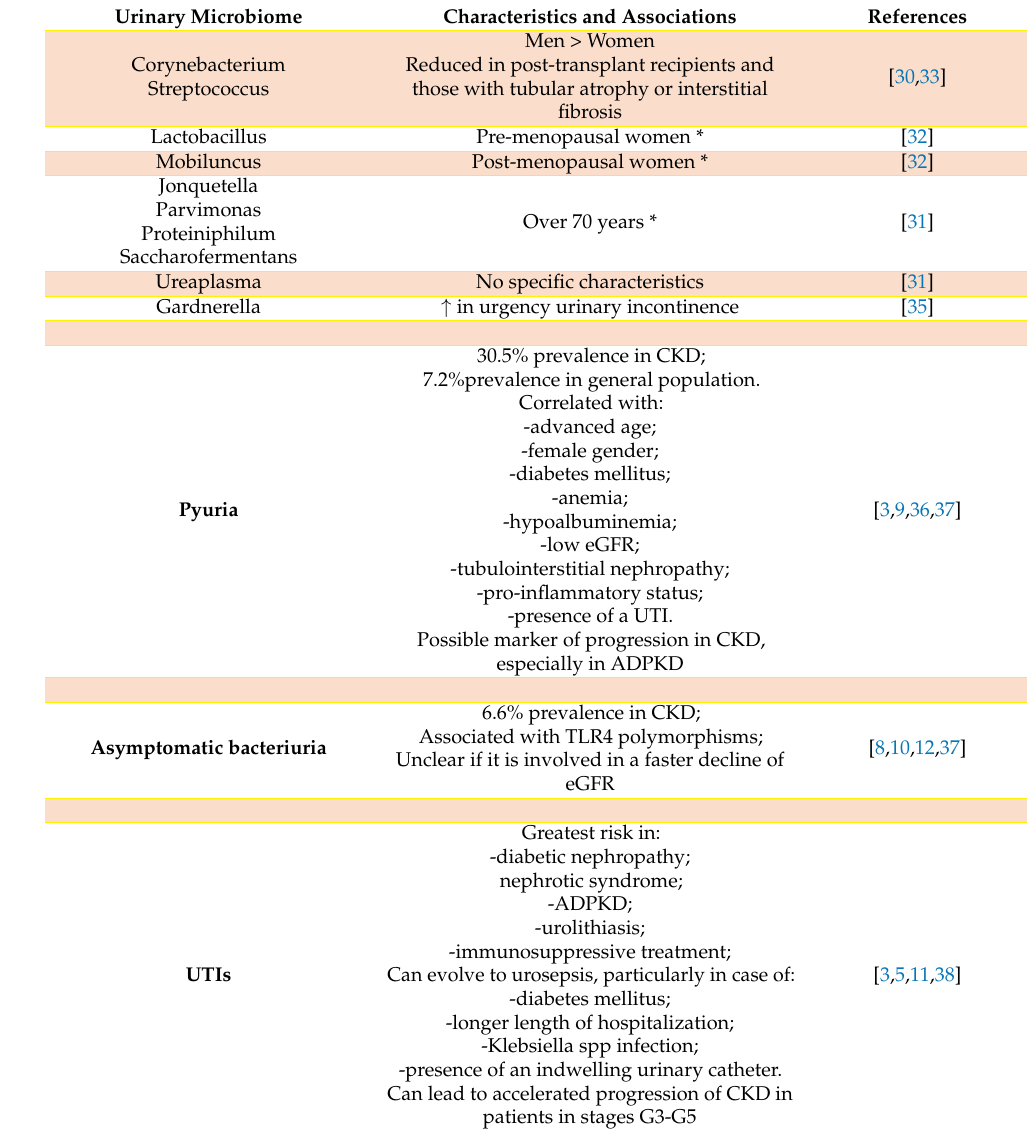
Table 2. The role and the characteristics of urinary microbiome, pyuria, asymptomatic bacteriuria and